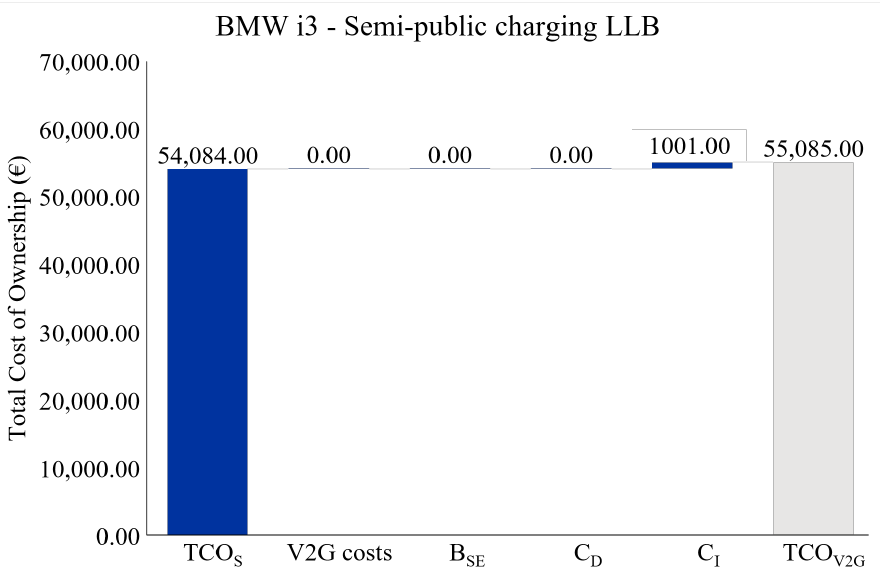
Figure A15. Standard and V2G TCO of a BMW i3 in a semi-public charging case providing LLB ( TCO S = Standard TCO, B SE = benefit of saved electricity costs from the grid, C D = direct compensa- tion, C I = indirect compensation, TCO V 2 G = V2G TCO); source: own